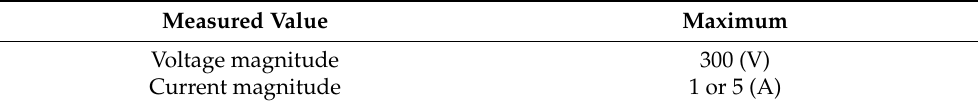
Figure 5. The developed microgrid control and communication device: ( a ) Block scheme of the MCCD. ( b ) fabricated prototype of MCCD. Table 2. Measurement range of MCCD for voltage and current